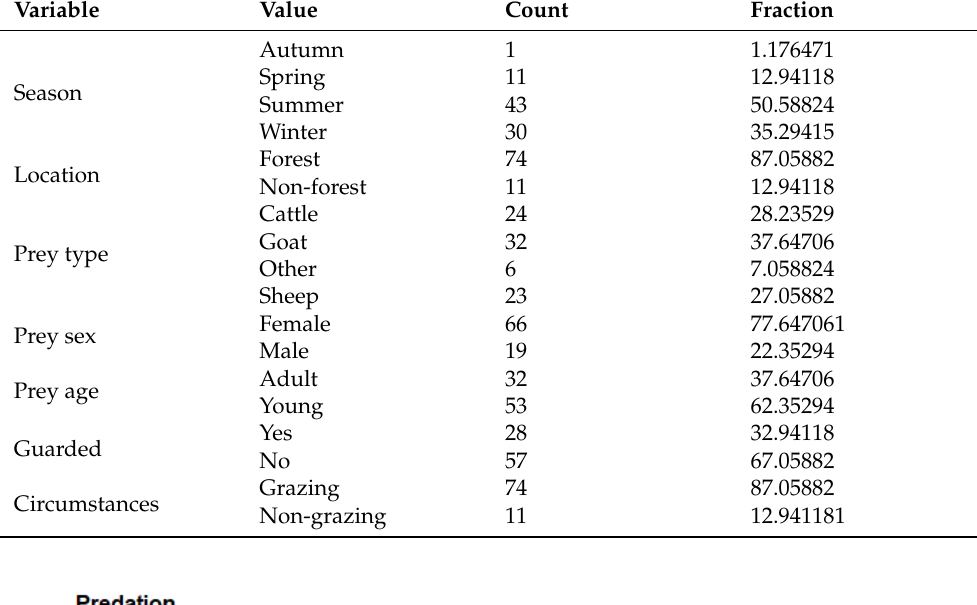
Table 2. Factors associated with livestock predation ( n = 85) by wolf used in predation-based PCA. Values shown include the number of livestock kills for each level (counts) and the percentages for each factor.